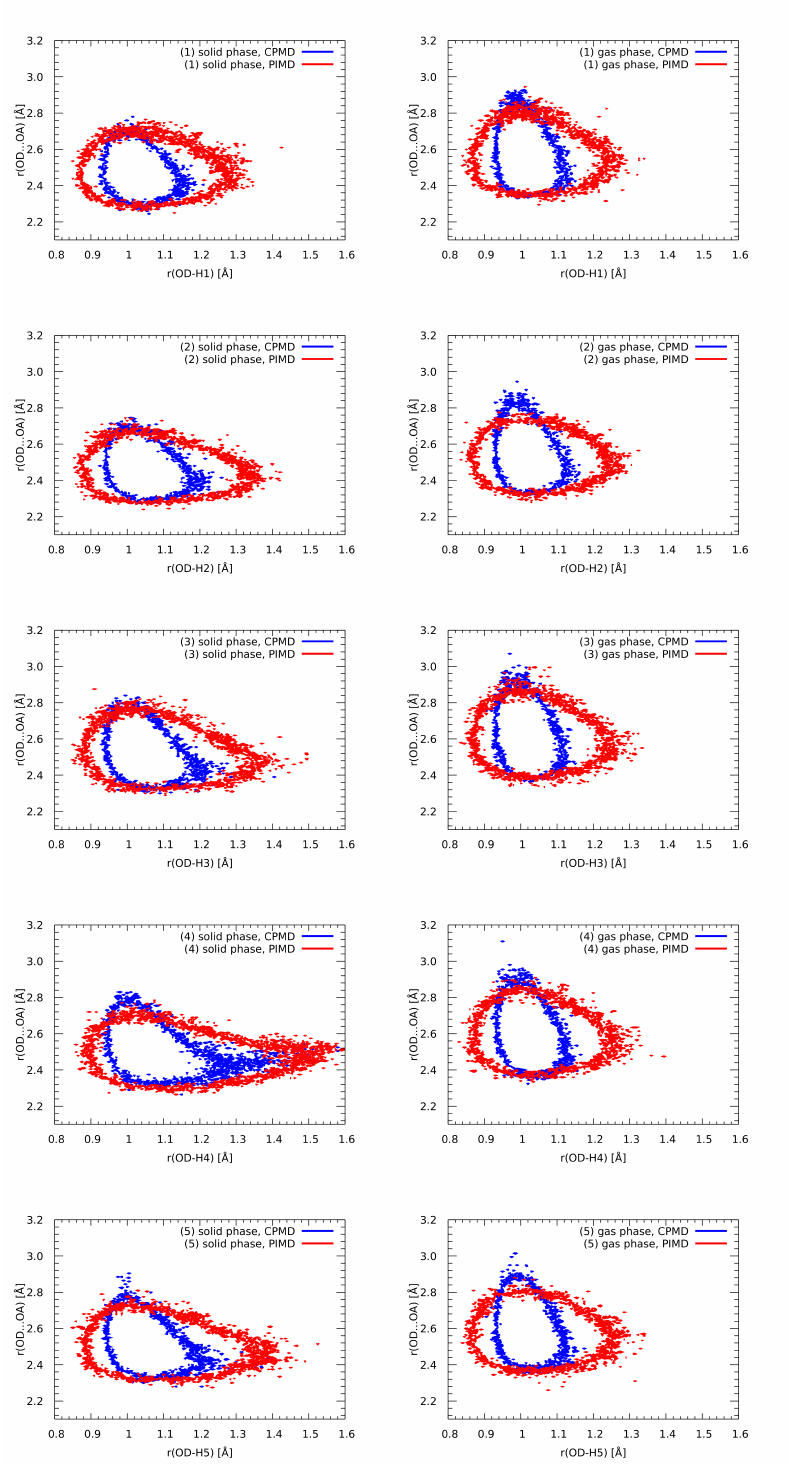
Figure 7. Impact of nuclear quantum effects on the OD•••OA and OD–Hn distances—comparison of the CPMD and PIMD simulations. Probability density isocontours drawn at the 1 Å − 2